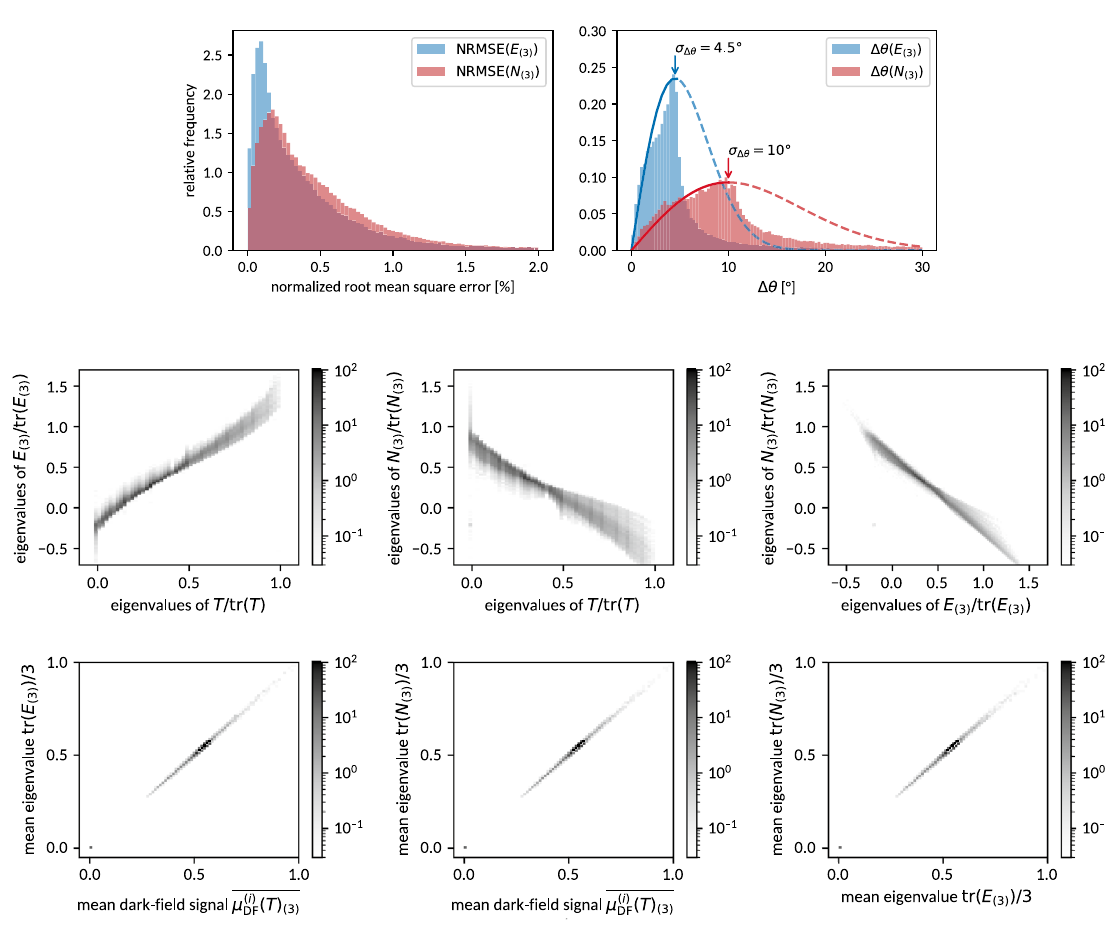
Figure 8. Comparison of NRMSEs, principal orientations, eigenspectra and mean signal intensities analog to Fig. 6, 7 when reconstructing tensors N and E from a reduced set of dark-field projections acquired along only three orthogonal projection trajectories (Fig. 4, indicated in